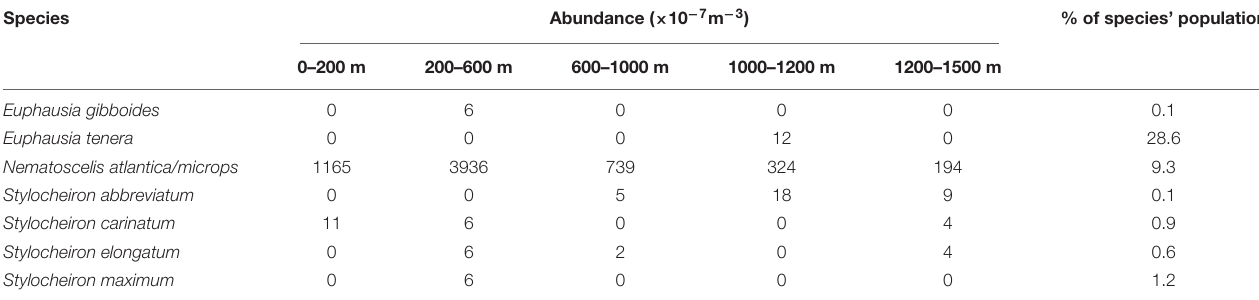
TABLE 3 | Abundances ( × 10 − 7 m − 3 ) of gravid euphausiid species for each depth range and the percent of the population that gravid females represent.